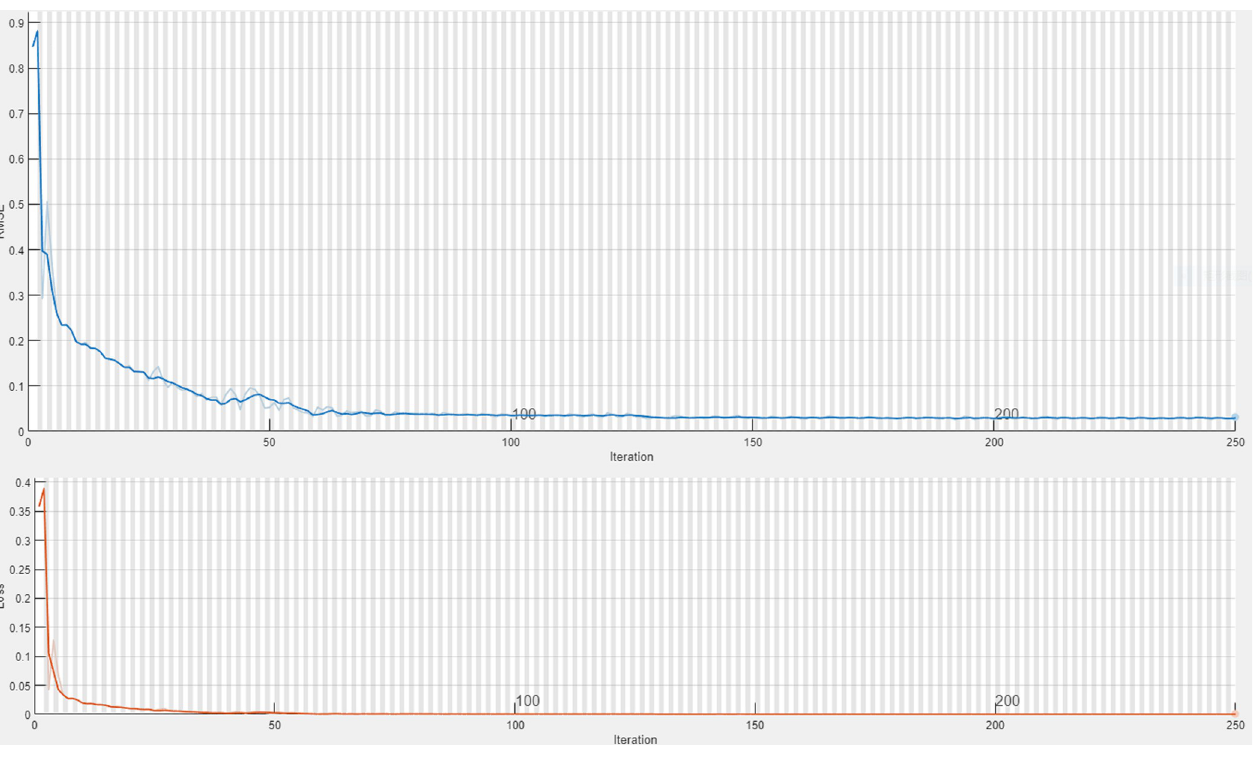
Fig 8. BP-LSTM model training